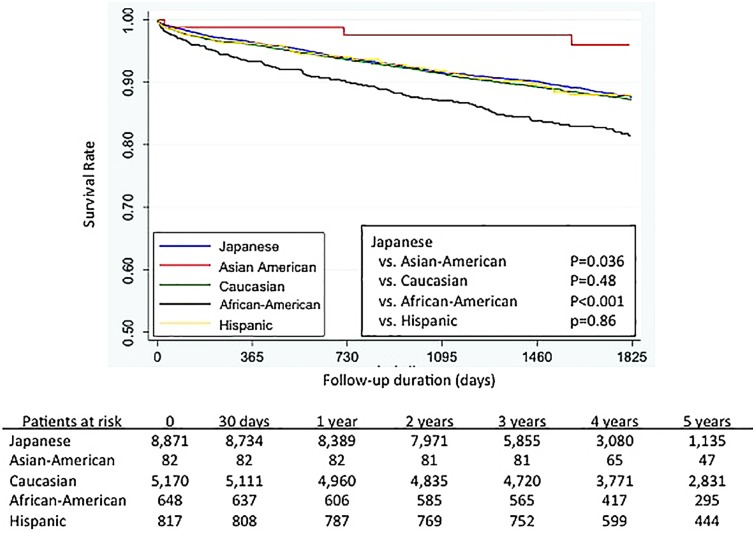
Kaplan-Meyer survival curves, based on patient ethnicity.